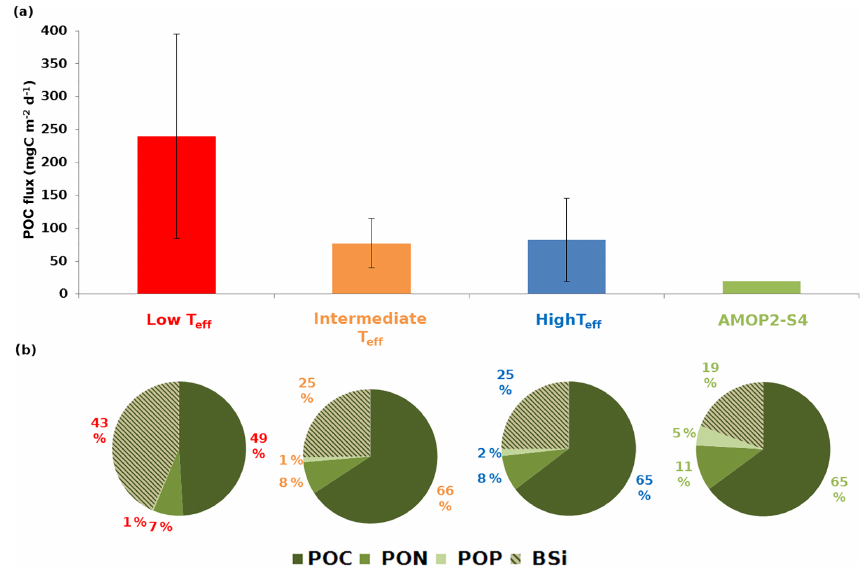
Figure 6. Average mass flux and particle composition at the upper sediment trap (34m) averaged by the main T eff ranges. (a) Histograms of POC fluxes in mgCm − 2 d − 1 (see Fig. 2) with error bars corresponding to the standard deviation. (b) Sector diagrams of particle composition (mol%) in terms of particulate organic carbon (POC), particulate organic nitrogen (PON), particulate organic phosphorus (POP) and biogenic silica (BSi). The values indicated as a percentage correspond to the abundance of one element relative to the sum of the four other elements analysed here for the OM. For more details, see Tables S1 and S2. Note that due to its specific OM quality at 34m, the AMOP2-S4 sample has been extracted from the intermediate T eff range and represented